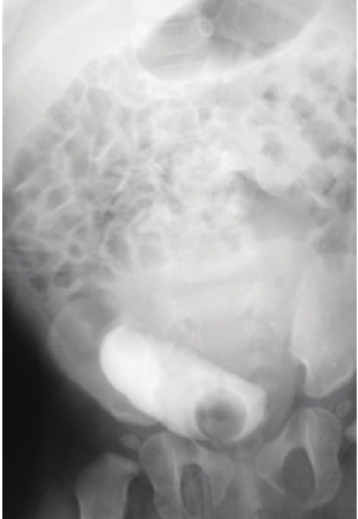
Figure 3: Preoperative VCUG. Image reveals no reflux but a urinary bladder which could not receive appropriate amount of contrast material due to severe compression secondary to